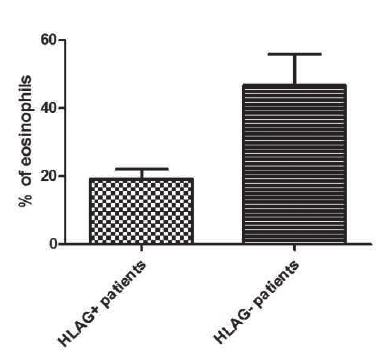
Figure 2 HLA-G expression and Prick Test positivity. Prick Test positive patients presented lower percentage of HLA-G positi- ve cells when compared with patients whose Prick test result was negative (p =